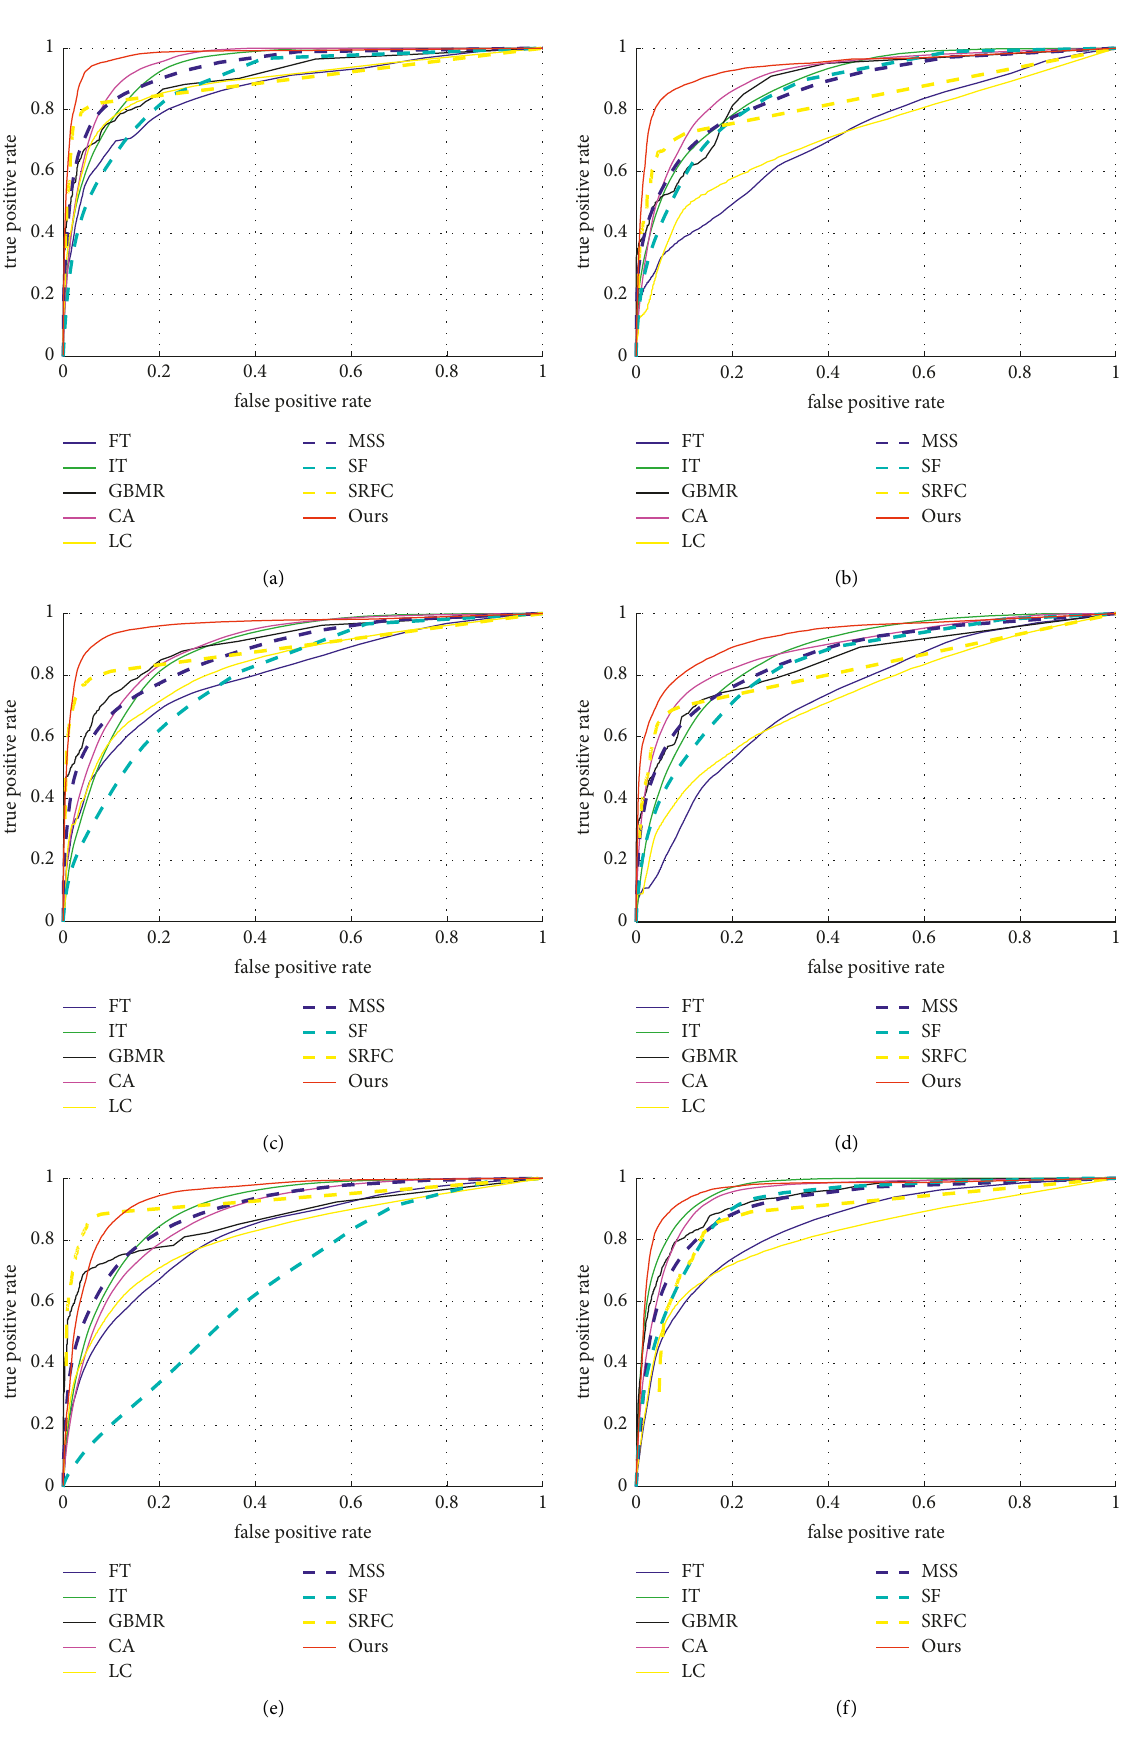
Figure 7: ROC curves over different datasets. (a) MASK10K; (b) SOD; (c) DUTS; (d) ECSSD; (e) HKU_IS; and (f)